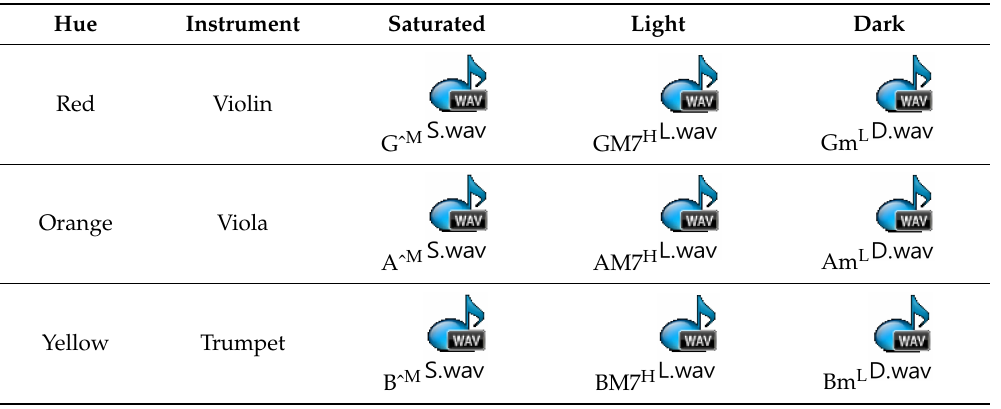
Table 2. Chord coding colors